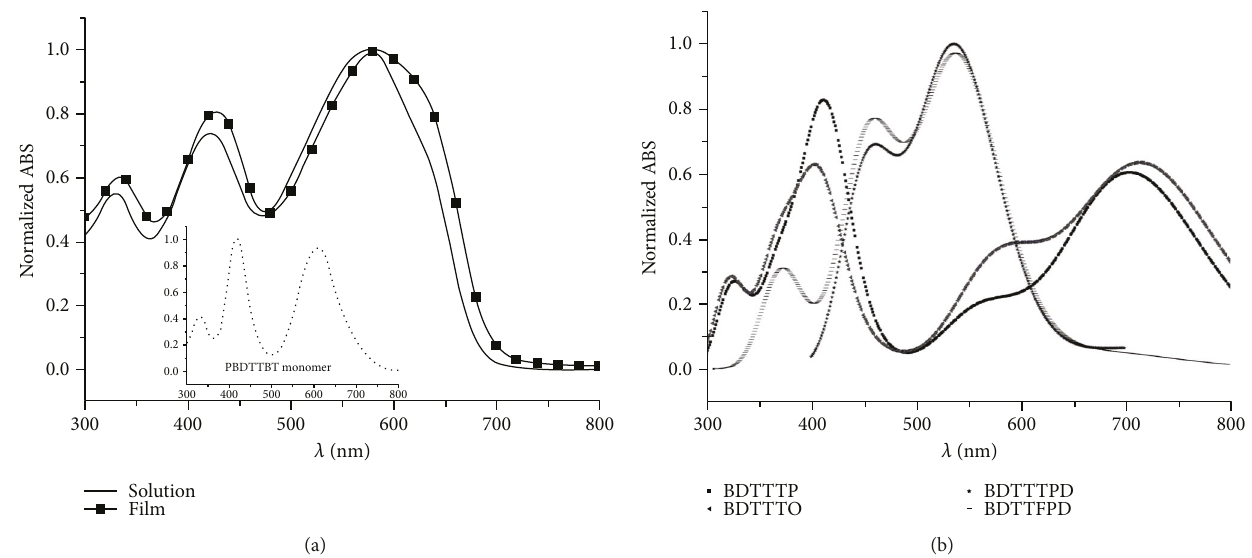
Figure 4: (a) Experimental absorption spectra of PBDTTBT as a fi lm and in chloroform solution [23] and simulated absorption spectra of PBDTTBT monomer (the smaller one) in chloroform solution. (b) Absorption spectra of monomers of the four designed copolymers in chloroform